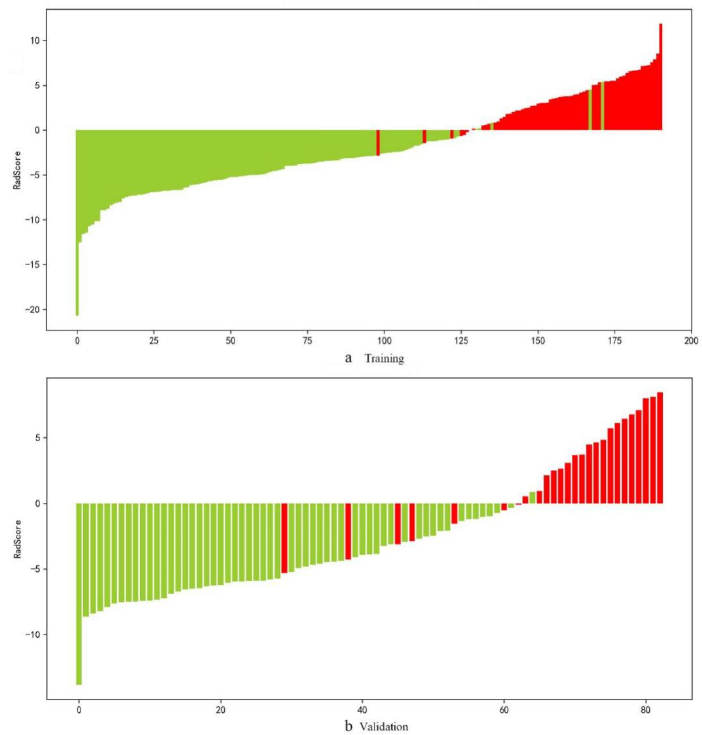
Figure 3. Bar diagrams in the training ( a ) and validation ( b ) groups. Up and down bars refer to the predicted malignant and benign lesions, respectively. Red and green bars refer to actual malignant and benign lesions, respectively.